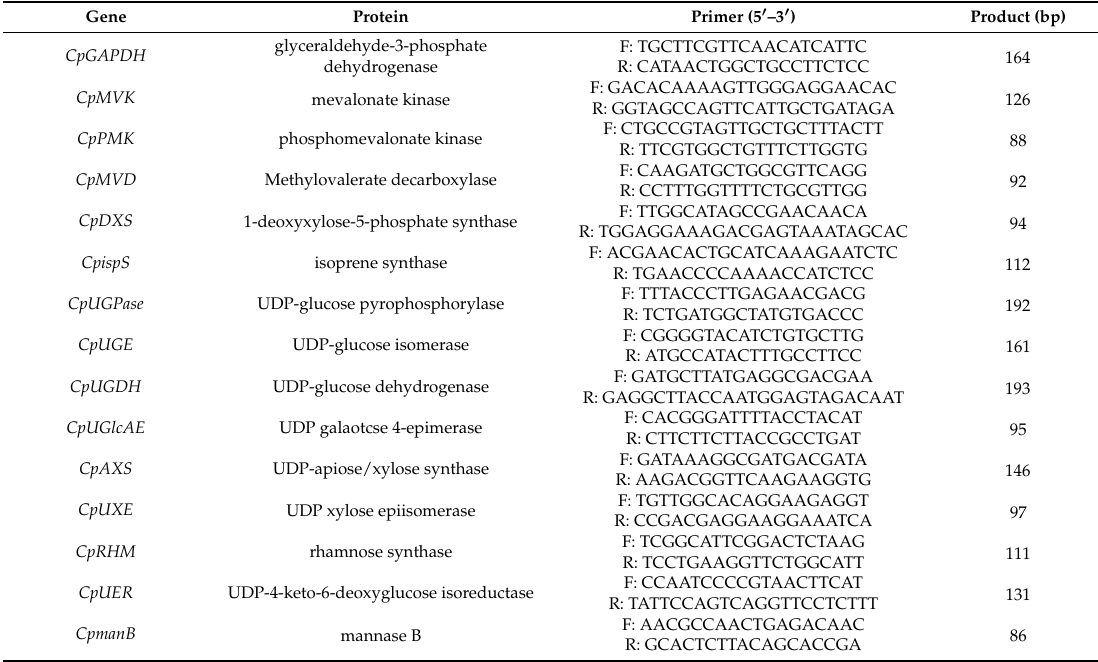
Table 2. Primer sequence used in this